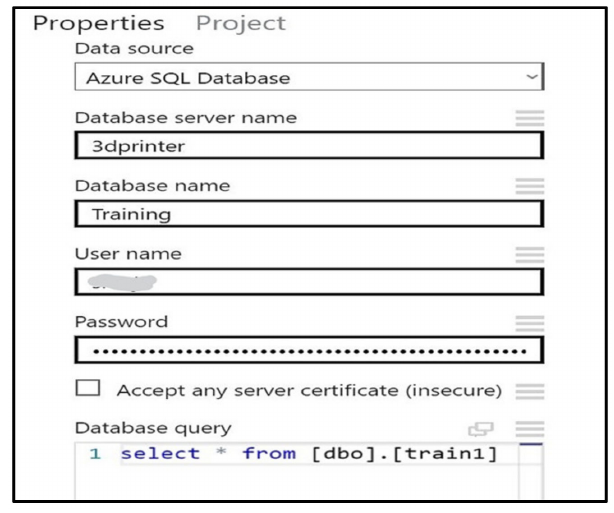
Figure 13. Import Module for server